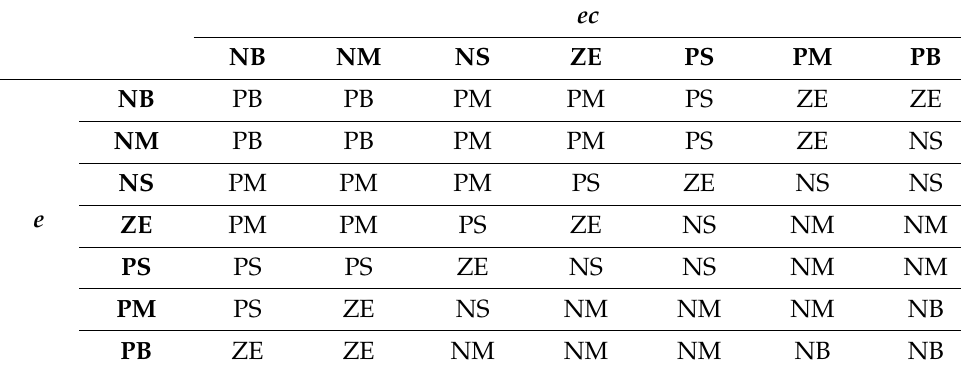
Table 1. Fuzzy Control Rule table of k p